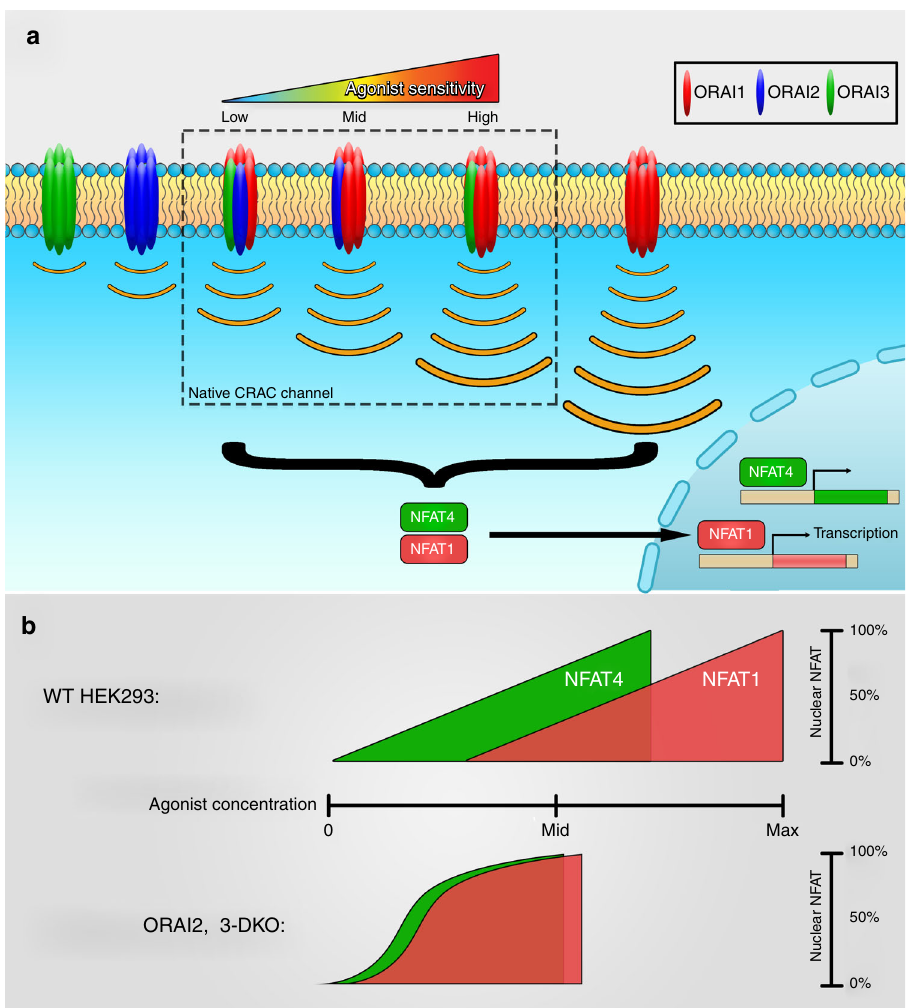
Fig. 8 Summary of fi ndings from the current study. a Native CRAC channels are constructed of ORAI isoform heteromers (dashed box). Incorporation of ORAI3 and ORAI2 with ORAI1 into hexameric CRAC channels fi ne-tunes SOCE to gradually match the strength of agonist stimulation. CRAC channels containing ORAI2 or ORAI3 or both will have weaker activity but will more readily activate through preferential interactions with STIM1 at low levels of store depletion. b In wild-type cells, ORAI2 and ORAI3 expand the range of sensitivity of receptor-activated Ca 2 + signals to induce differential NFAT isoform nuclear translocation. In their absence, both NFAT1 and NFAT4 are substantially induced in response to low concentrations of agonist. Although native ORAI2 and ORAI3 can mediate SOCE when other ORAI isoforms are absent, they are incapable of supporting NFAT nuclear translocation. Whether ORAI isoform homohexamers exist under native conditions is uncertain. Our data suggest that ORAI3 and ORAI2 isoforms are unlikely to function independently of ORAI1 under native conditions. However, the precise stoichiometry or stoichiometries of native CRAC channels is likely cell type-speci fi c and requires further 3 homohexamers, 33 heterohexamers for 2 isoform combinations (11 for each 2 ORAI isoform combinations), and 56 hetero- hexamers for 3 isoform combinations. (see methods and Sup- plementary Fig. 12 for calculations). The expression of concatenated heterohexamers with de fi ned numbers of each ORAI isoform in ORAI-TKO cells can help determine whether the position of each isoform within the hexamer is critical for its properties or only the number of subunits of that isoform mat- ters. Whether native CRAC channels are combinations ORAI1/ ORAI3 and ORAI1/ORAI2 heterohexamers, or combinations of ORAI1/ORAI2/ORAI3 heterohexamers, or both is an impor- tant question that remains to be answered experimentally.